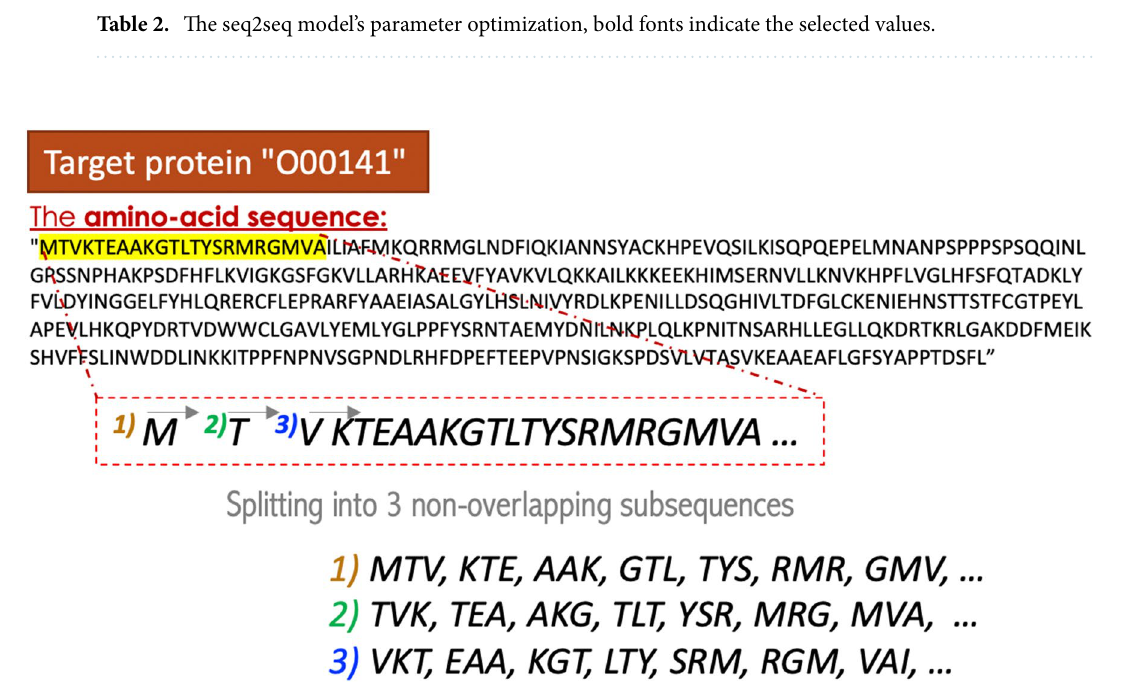
Figure 3. The process used to generate three lists of non-overlapping biological words that served as the corpus for ProtVec